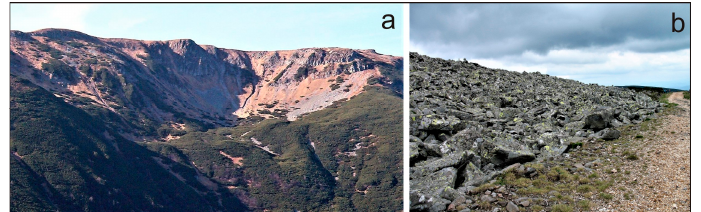
Figure 17. Glacial and periglacial features in the C ă limani Mountains ( a ) Glacial cirque beneath the Re ț i ț i ș peak to the north, ( b ) Block field of periglacial origin formed of frost-shattered rock fragments beneath the Re ț i ț i ș peak to the south. (Photo credit: Viorel Chiri ță ). According to Szakács and Chiri ță [43], the lower topographic realm of the C ă limani Mountains is characterized by intense fluvial erosion due to a dense hydrographic net- work with steep slopes, narrow gorges, waterfalls, and small erosional basins as well as colluvial and alluvial glacis and piedmont features. Incision and relief fragmentation is particularly intense on the “volcanic plateau” areas and on slopes with high relief energy inside the caldera. The average values of vertical fragmentation in the central part of C ă li- mani Mountains are between 150 and 450 m on the southern and the eastern external slopes of the caldera, and over 400–650 m on the northern inner slopes of the caldera. Differential mechanical weathering and wind-generated corrasion locally resulted in spectacular rock formations and ruin-like landscape features in coarse volcaniclastic rocks, showing intricate irregular morphologies of residual relief (10 to 35 m high), such as those of the “12 Apostles” group (Figure 18). Figure 18. Two of the spectacular “12 Apostles” residual rock formations resulted from selective wind erosion of volcaniclastic rocks in the north-western part of the C ă limani Mountains (Photo credit: Viorel Chiri ță ).